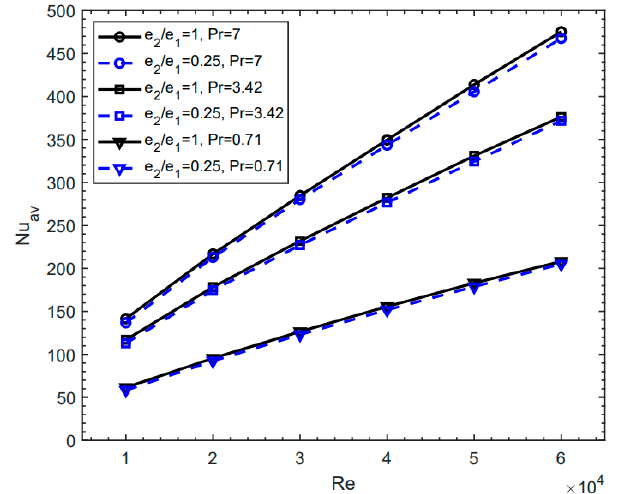
Figure 6. Average Nusselt number (Nu av ) at different values of Pr and two rib height ratio (e 2 /e 1 ) values.